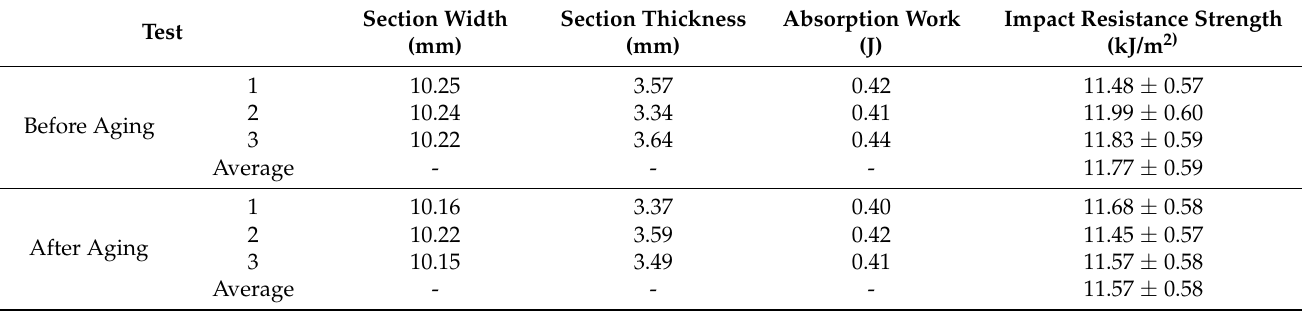
Table 2. The impact resistance properties of the B 4 C/TiO 2 /polyimide molded plate.